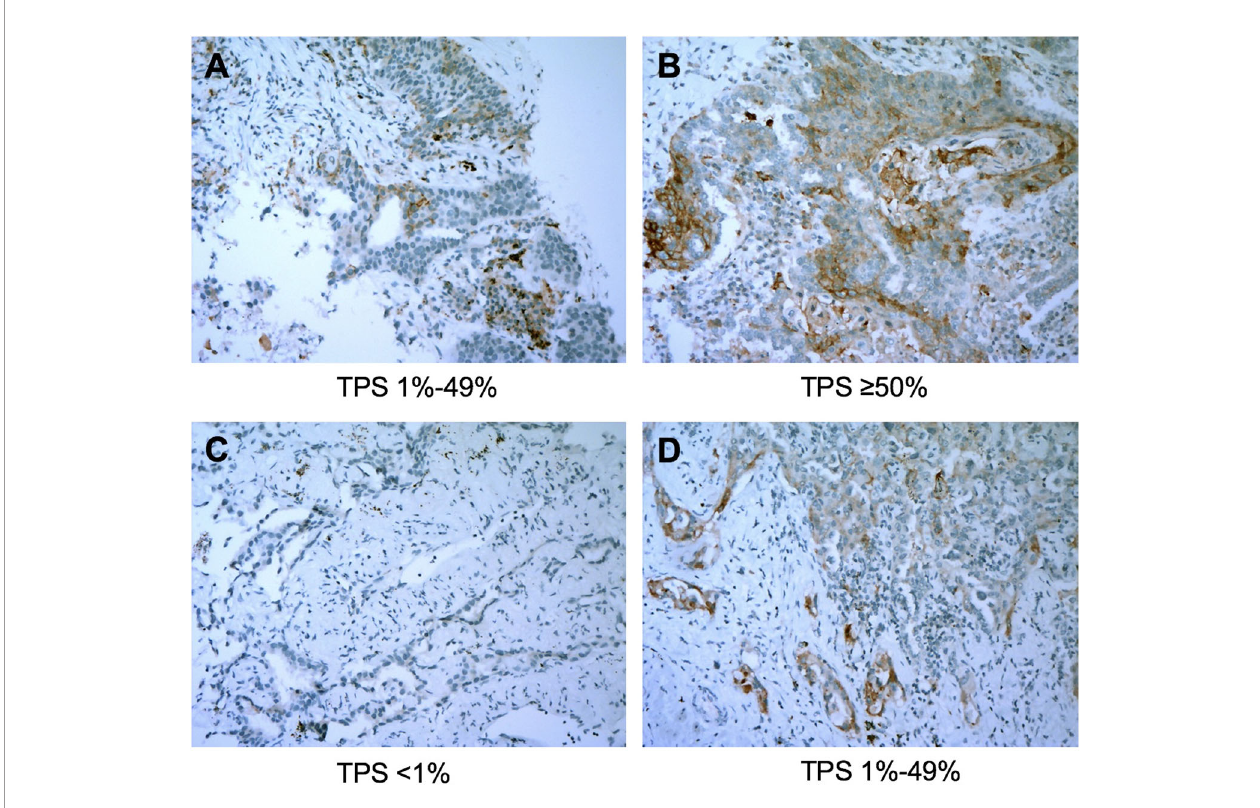
FIGURE 3 | Representative images of discordant cases between biopsy specimens (left panel) and matched resected specimens (right panel). The PD-L1 Tumor Proportion Score (TPS) was 10% in the biopsy tumor specimen (A) and was ≥ 50% in the corresponding resected tumor (B) . PD-L1 TPS in the biopsy specimen was <1% (C) and was 20% in the matched surgical specimen (D) . All images are at ×40 magni fi cation.